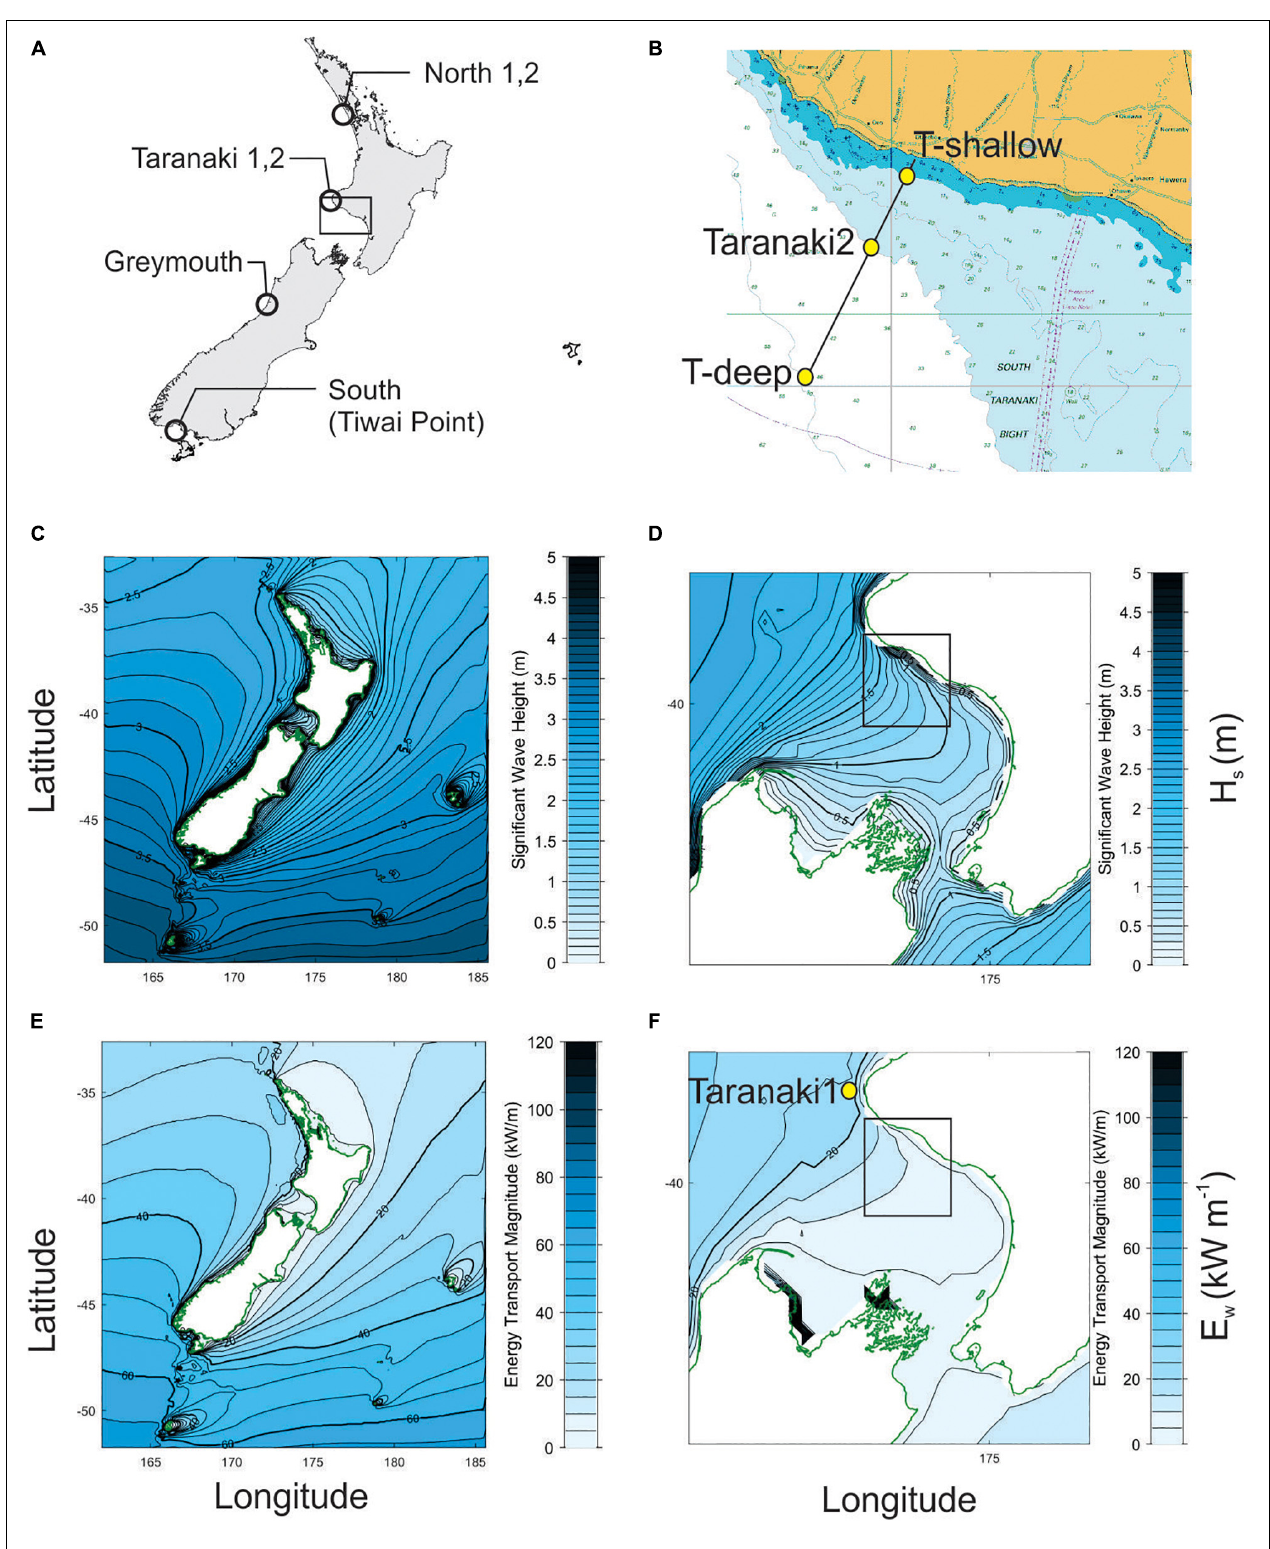
FIGURE 2 | Regional setting and resources showing (A) New Zealand location diagram, (B) case study region inset from panel (A) with test locations (Taranaki-2 and deeper and shallower equivalents), and hindcast simulated 1957–2002, on a ∼ 10 km resolution NZ domain, using ERA40 winds showing (C,D) mean H S and (E,F) wave energy flux E w . Panels (D,F) show the region in the location diagram (B) .